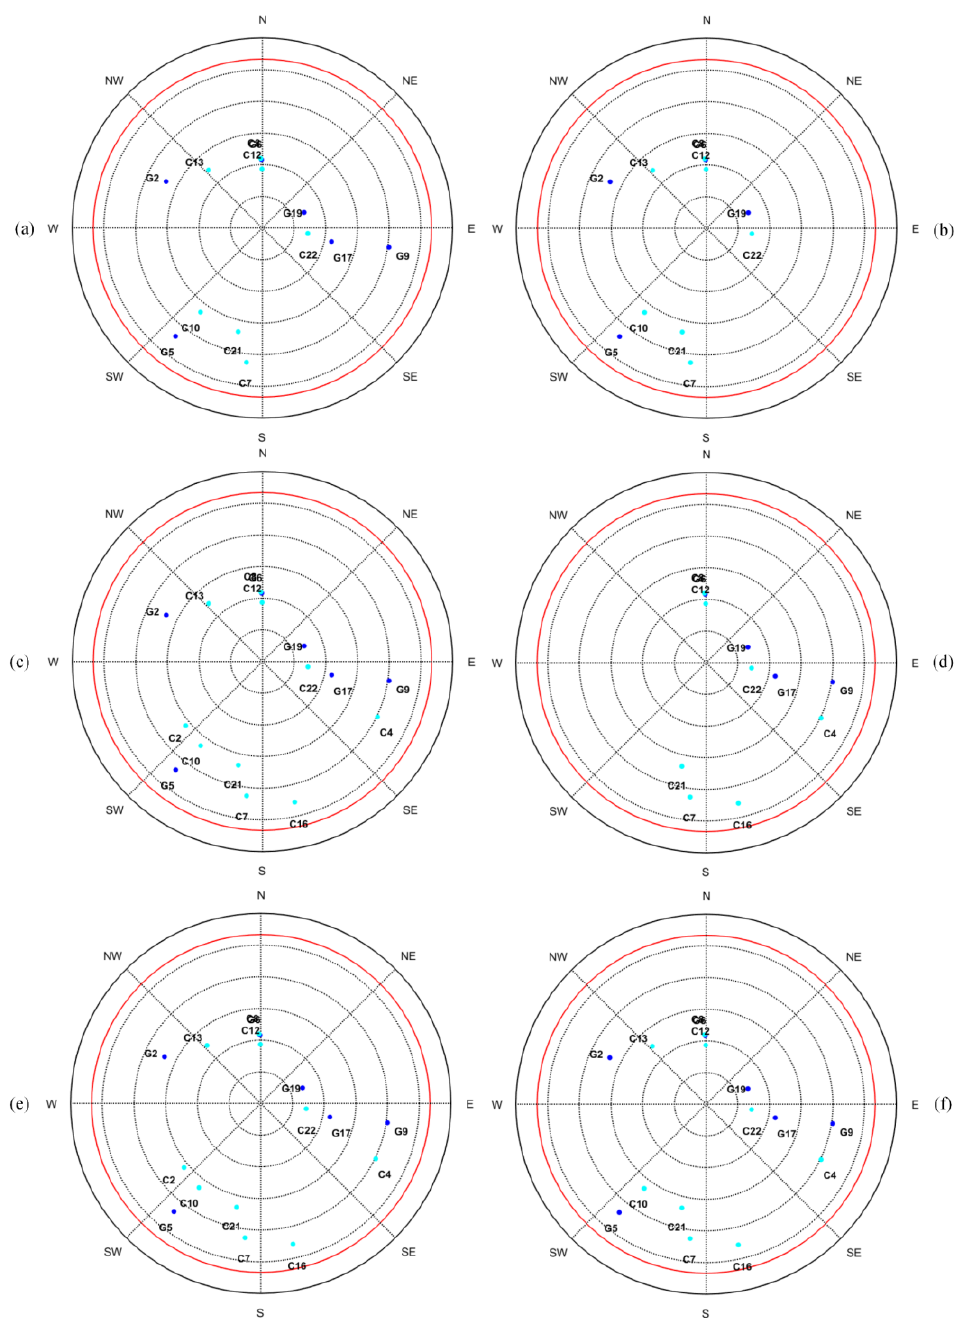
Figure 5. Sky plots of available satellites from multi-GNSS system above the vehicles’ horizon at the first epoch for ( a ) vehicle 1 in the open area, ( b ) vehicle 1 below the viaduct, ( c ) vehicle 2 in the open area, ( d ) vehicle 2 below the viaduct, ( e ) vehicle 1 and vehicle 2 (the connected vehicles) in the open area, and ( f ) vehicle 1 and vehicle 2 (the connected vehicles) below the viaduct. The multi-GNSS system is used including GPS (in blue) and the BeiDou Navigation Satellite System (BDS) (in cyan). The serial numbers of GPS satellites start with letter “G” and those of BDS start with letter “C”.